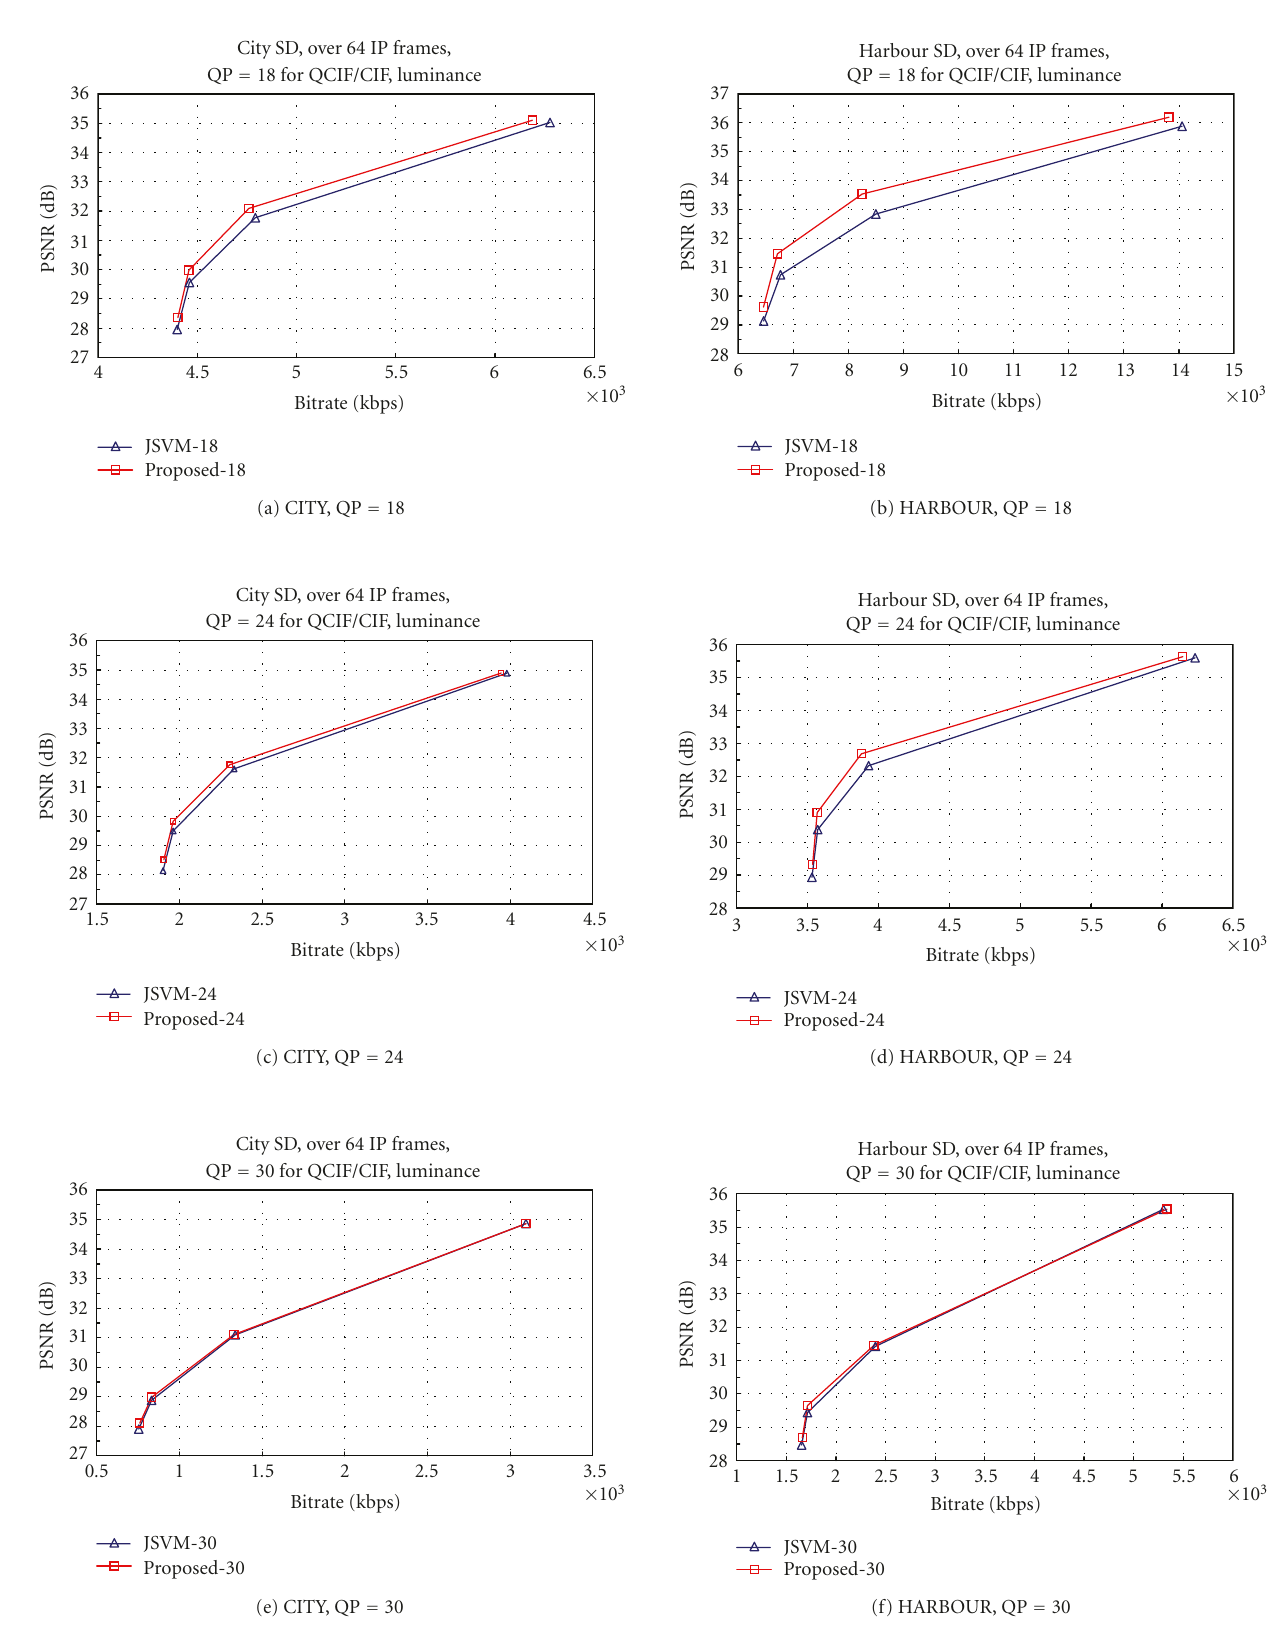
Figure 8: PSNR-rate curves for the luminance component of (a) CITY and (b) HARBOUR SD 30Hz over 64 I and P frames, with GOP size = 1 and Intraperiod = 8, when QPs for QCIF/CIF are 18, 24,